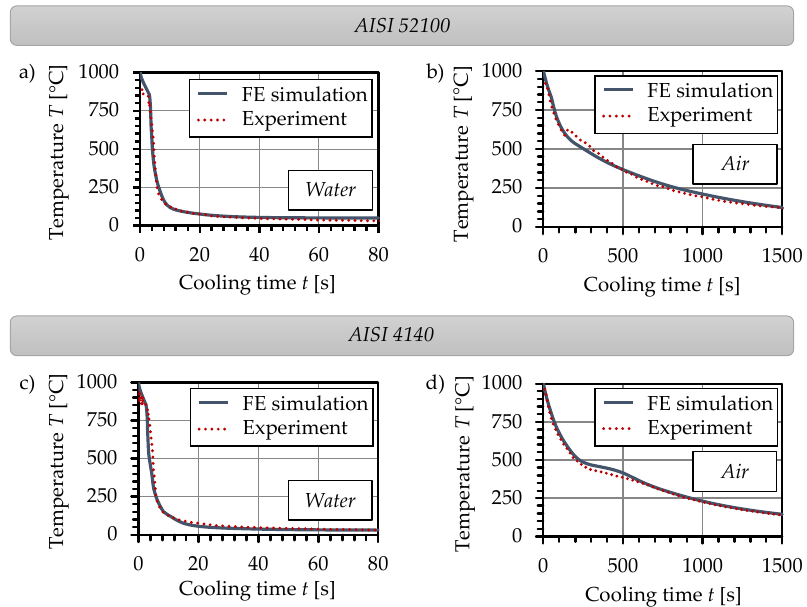
Figure 6. Comparison of the temperature curves at the measuring point TC from the experiments and simulations for the cooling of AISI 52100 in water ( a ) and air ( b ), and for AISI 4140 in water ( c ) and air ( d